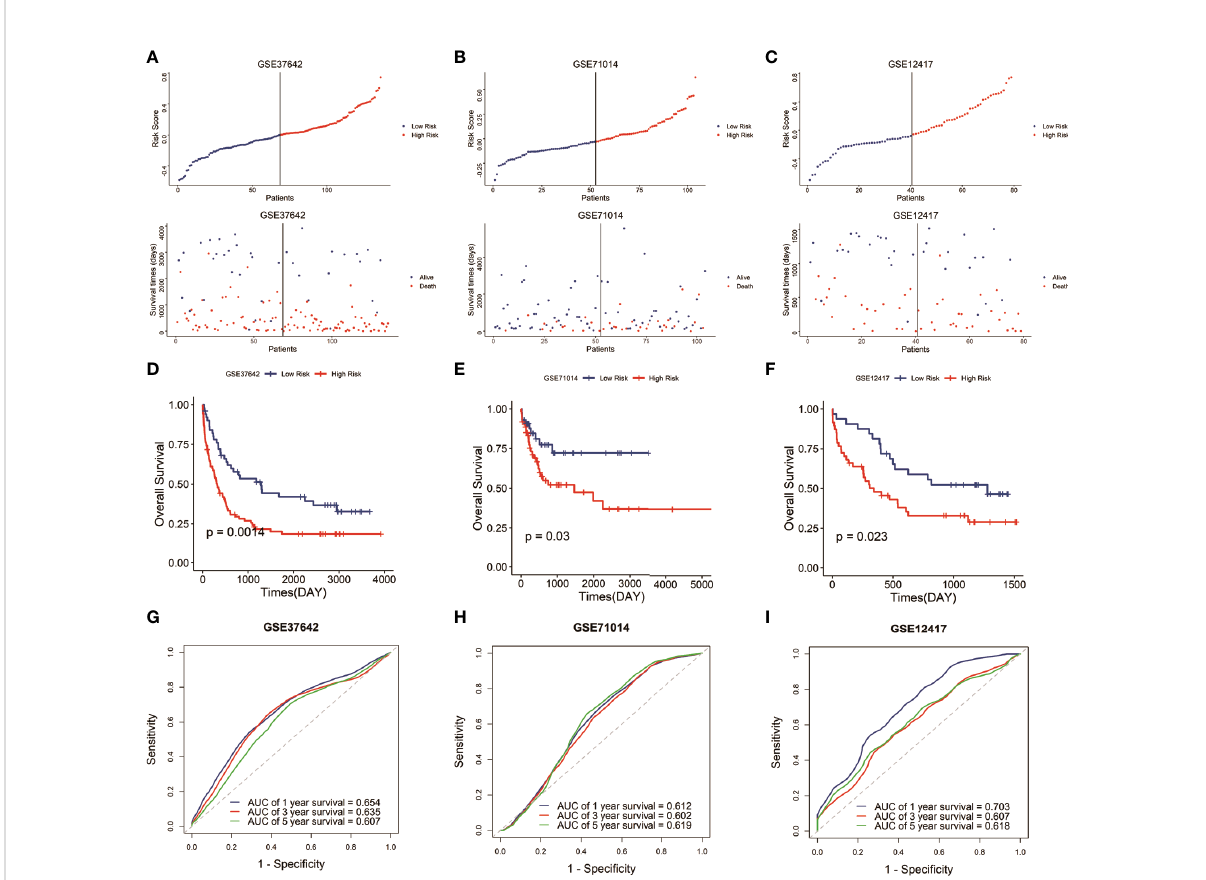
FIGURE 2 Validation of the signature in the GEO datasets. (A – C) Distribution of the risk score and survival status of each sample in the three validation cohorts. (D – F) Survival analysis of the two risk groups classi fi ed by the signature in the three testing datasets. (G – I) ROC curves to predict the 1-, 3-, and 5-year survival in the three testing